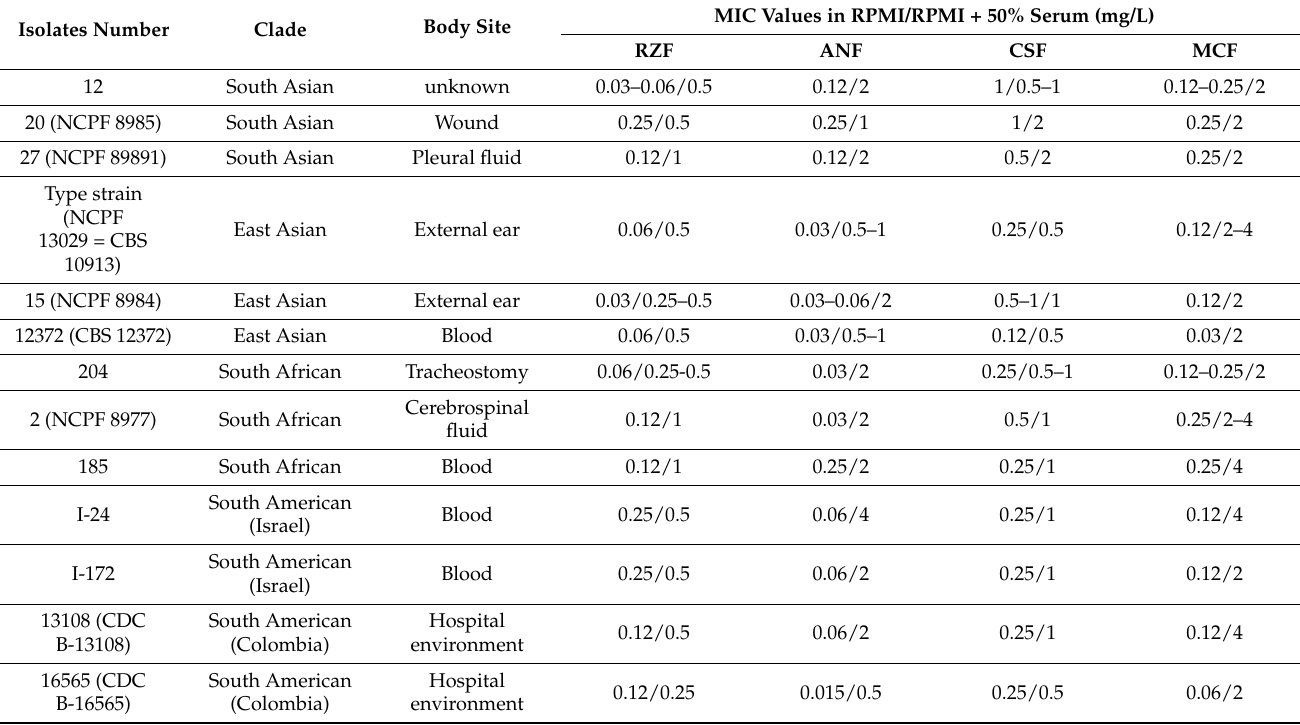
Table 1. Minimum inhibitory concentration (MIC) values of rezafungin (RZF), anidulafungin (ANF), caspofungin (CSF), and micafungin (MCF) in RPMI-1640 − /+ 50% human serum against Candida auris isolates and type strain. MICs were determined three times using the Clinical Laboratory Standars Institute broth macrodilution